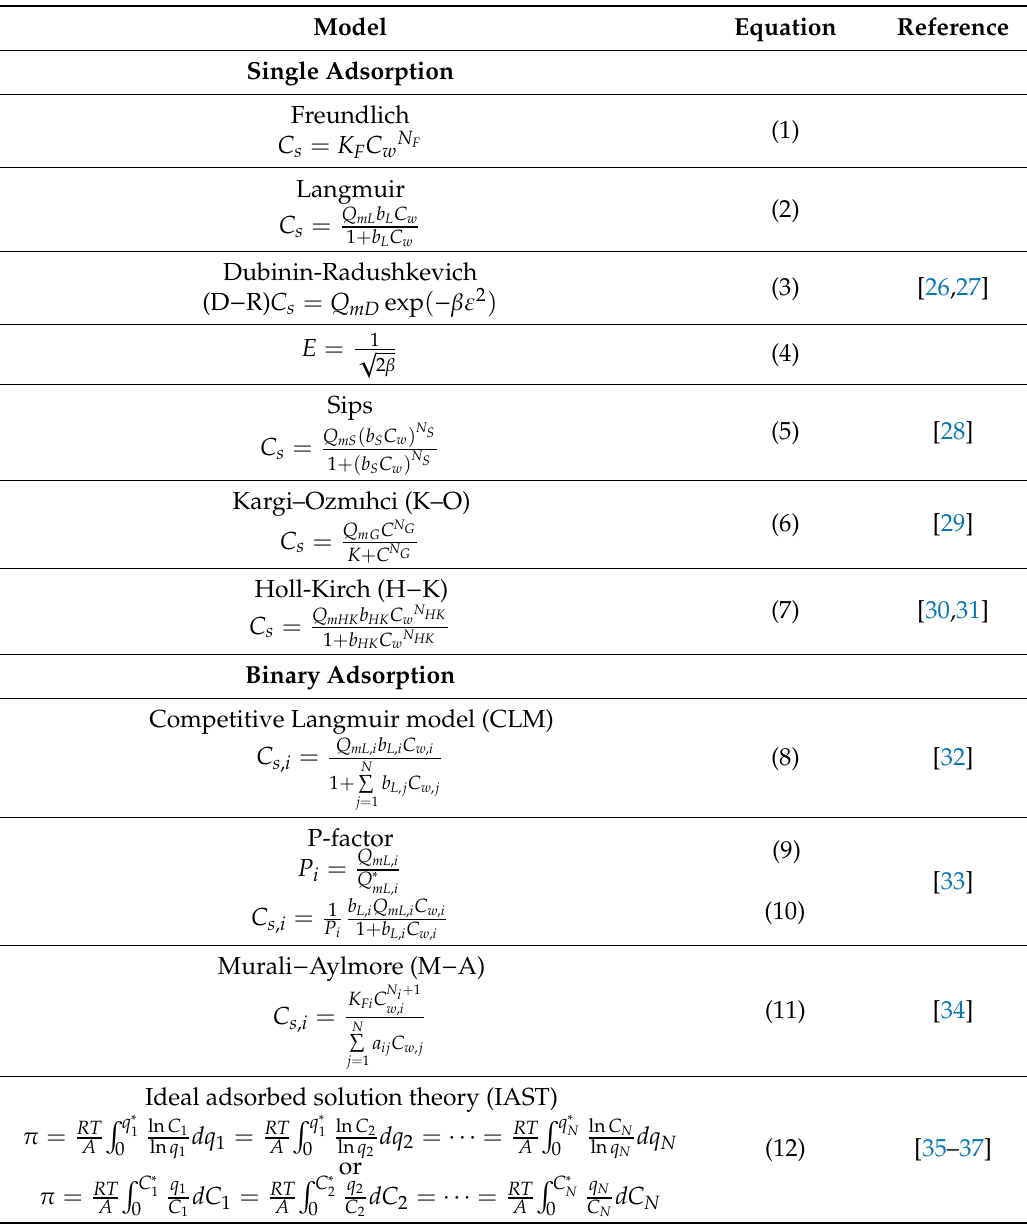
Table 2. Adsorption isotherm